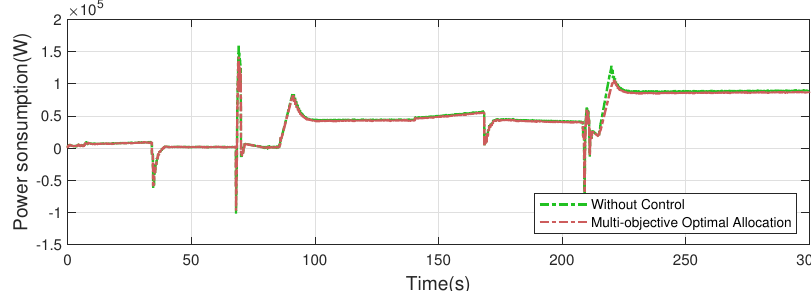
Figure 13. Instantaneous power consumption.